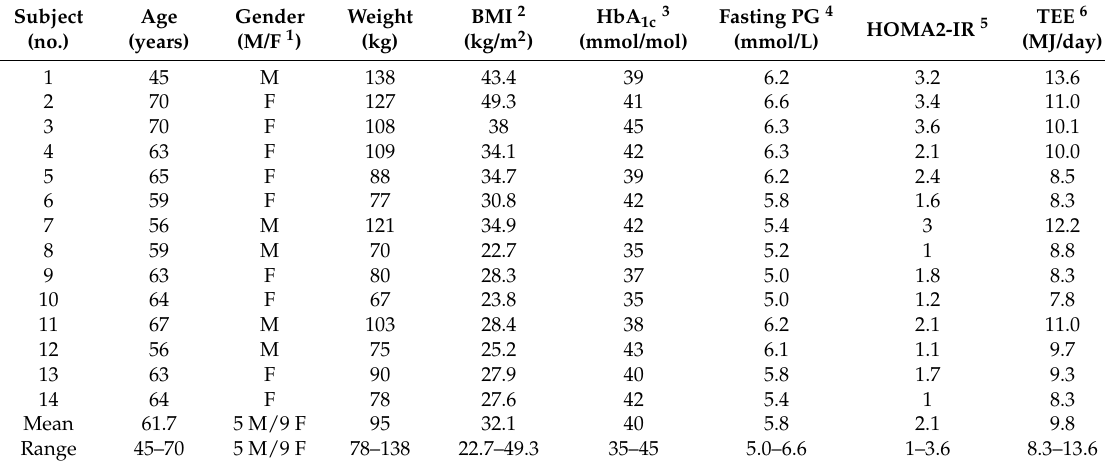
Table 1. Baseline characteristics of